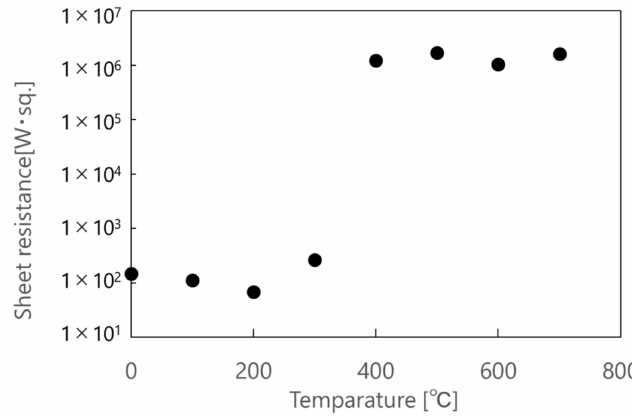
Figure 8. Sheet resistance dependence on annealing temperature of the fabricated